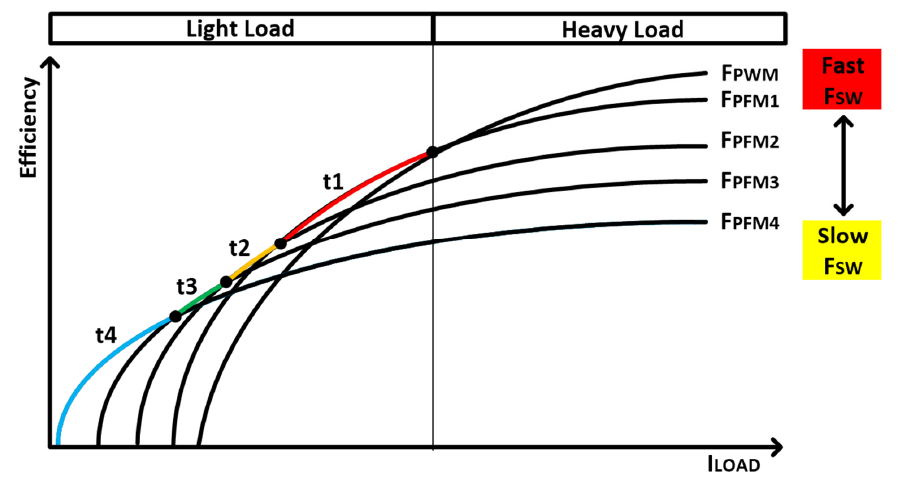
Figure 5. Switching frequency dependent efficiency difference in light-load conditions.